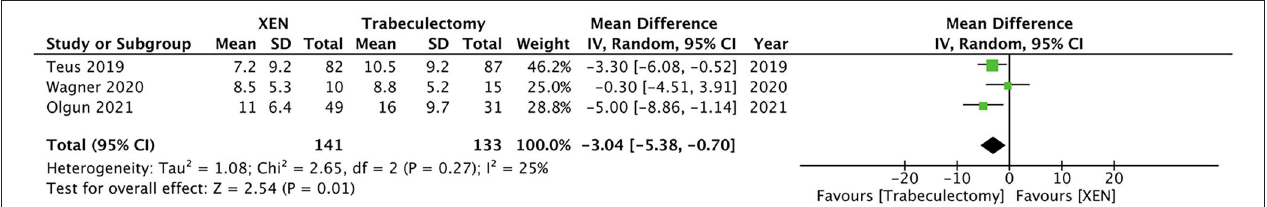
FIGURE 4 | Mean difference (MD) of the reduction in intraocular pressure between the patients after XEN implantation and trabeculectomy.